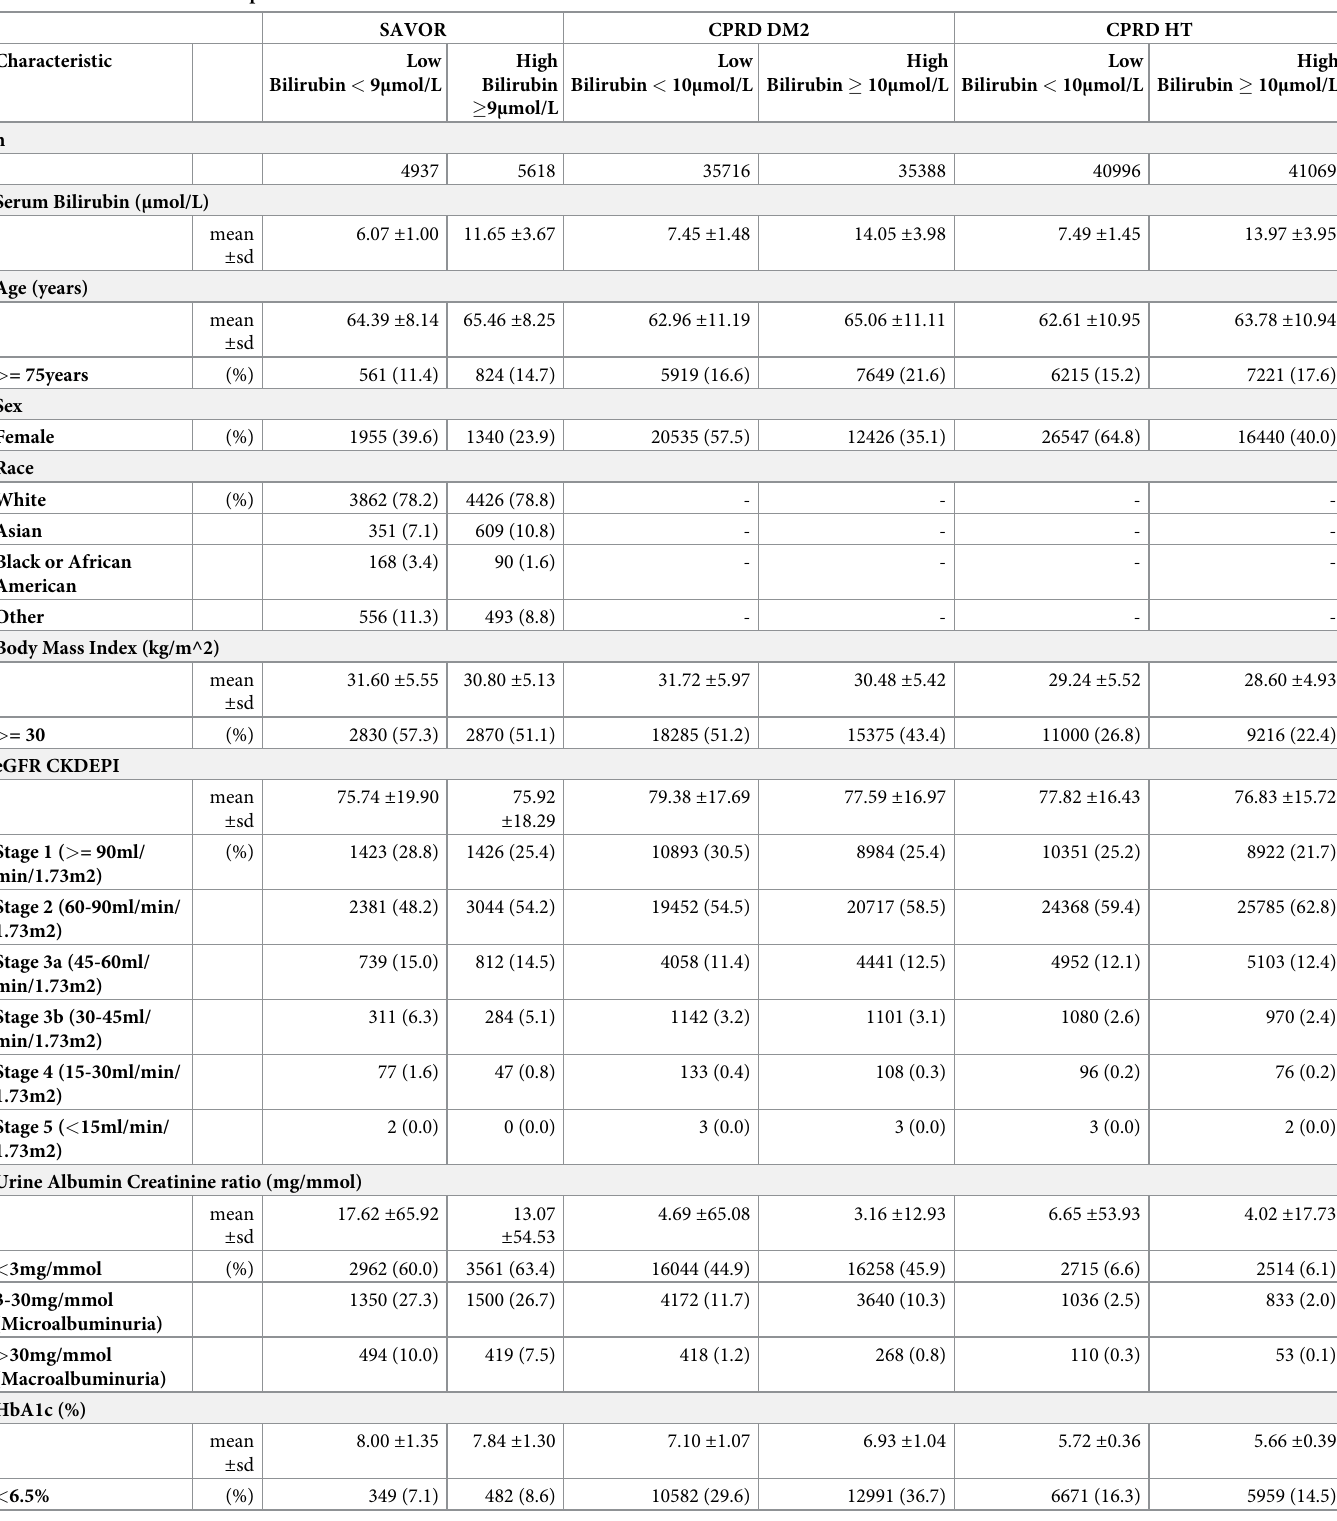
Table 1. Characteristics of the patients at baseline �